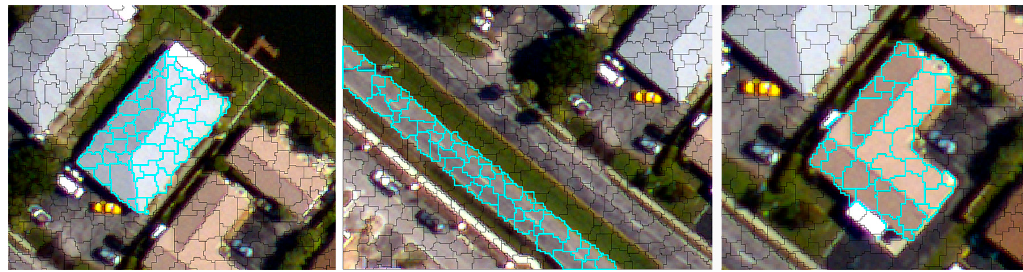
Figure 1. Examples taken from aerial images with three false-color bands and 0.32-m spatial resolution. From left to right, objects of three targets with different shapes are respectively highlighted.